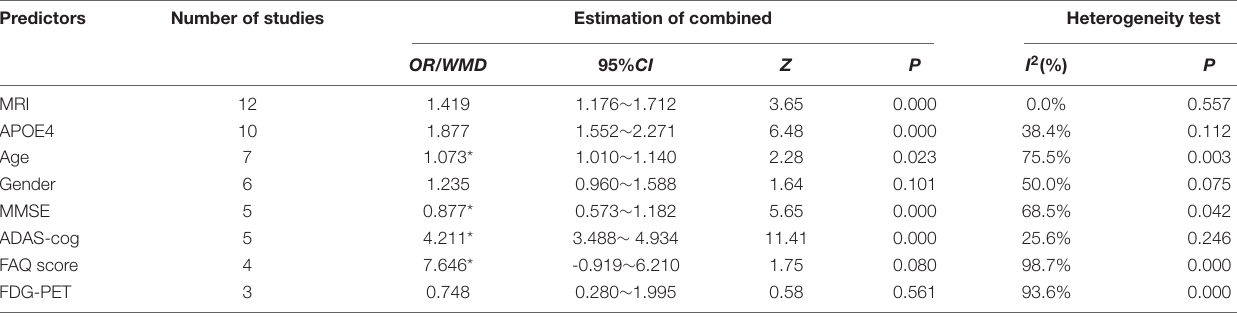
TABLE 3 | Results of meta-analysis for predictive factors. Predictors Number of